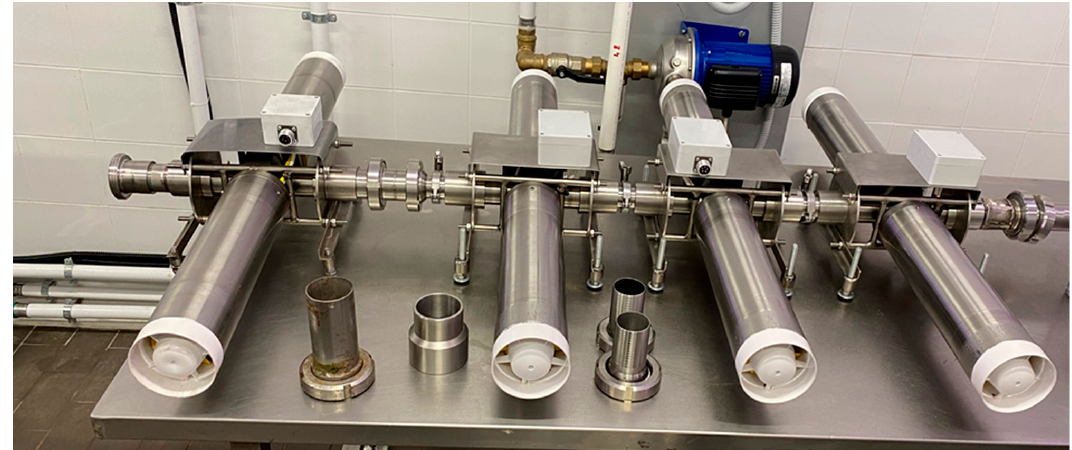
Figure 1. 4 x US devices .